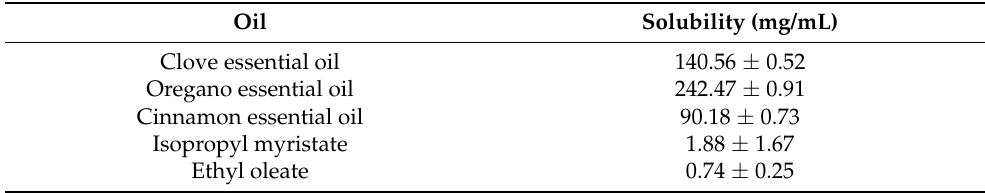
Table 4. Values of fluconazole solubility in various essential and synthetic fixed oils.